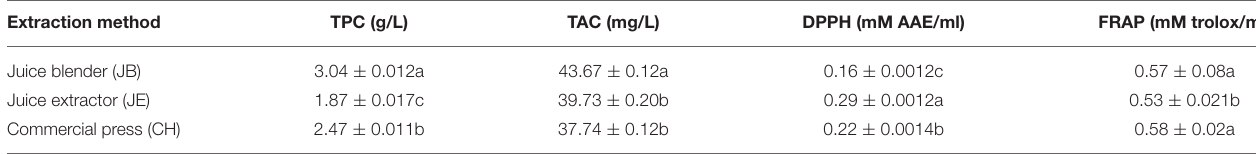
TABLE 5 | Phytochemical and antioxidant properties of pomegranate juice (cv. Wonderful) extracted by using three different methods. Extraction